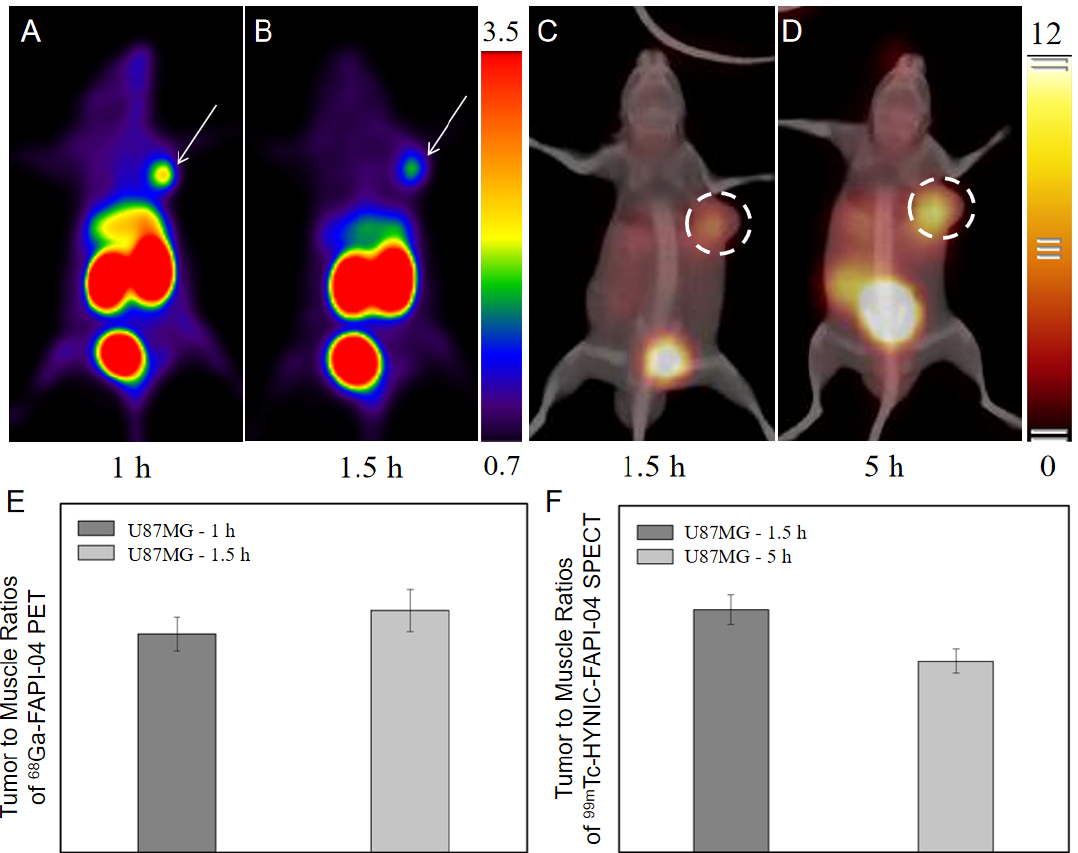
Figure 5. 68 Ga-FAPI-04 PET images of FAP-positive tumors at different time point ( A , B ) and 99m Tc-HYNIC-FAPI-04 SPECT images of FAP-positive tumors at different time point ( C , D ). The comparison of ratios of tumor to muscle between 1.5 h P.I. and 5 h P.I. in 68 Ga-FAPI-04 PET ( E ) and 99m Tc-HYNIC-FAPI-04 SPECT ( F ). The white arrow and white dotted circles all pointed to FAP-positive tumors.